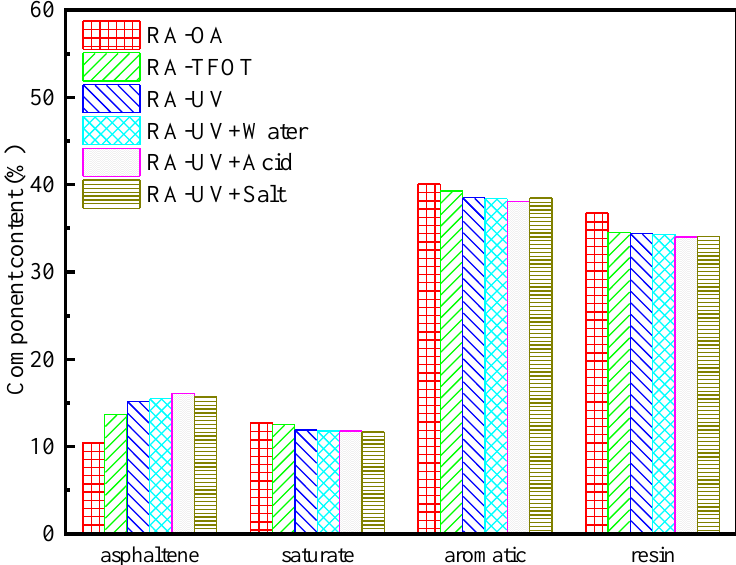
Figure 7. Four components of rubber asphalt after UV aging under different environmental conditions. Note: RA-OA is rubber asphalt-original asphalt.